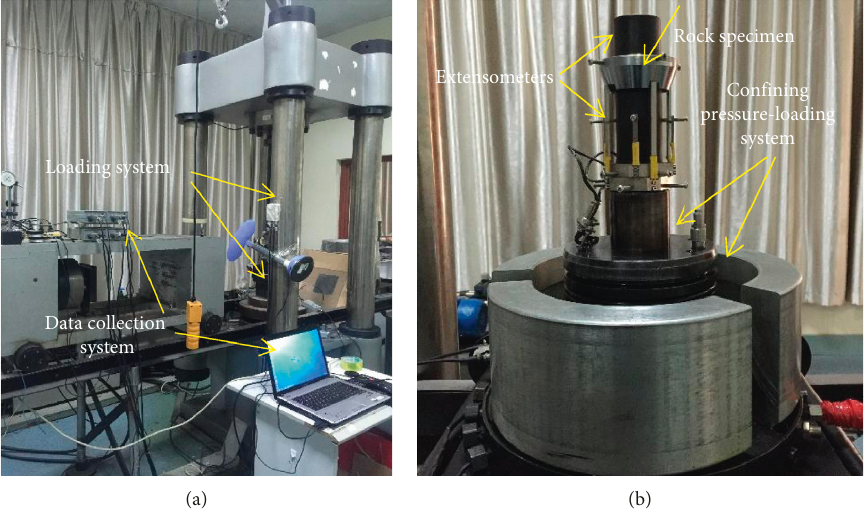
Figure 2: Test equipment. (a) Rock triaxial testing system. (b) Extensometers.